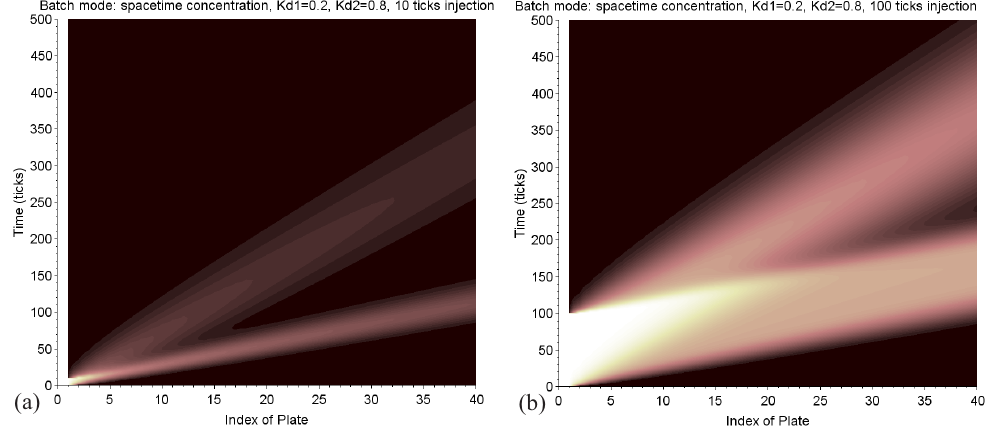
Figure 9. Batch mode: in these two figures, the space-time concentration map is displayed, where each colored point encodes the value m k n . The lowest trace is the path of the solute of K d 1 = 0.2 and the upper one is related to K d 2 = 0.8. The left picture ( a ) is related to a 10-tick injection, the right one ( b ) to 100 ticks. In the latter case, the two peaks are larger and are not completely